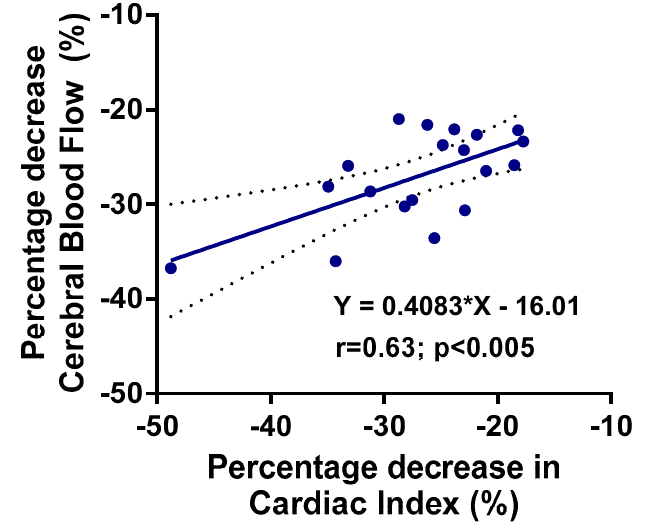
Figure 2. Stroke volume index in ml/m 2 supine and at the end of a 20 degree tilt in severe ME/CFS patients (panel A ). Cardiac index in l/min/m 2 supine and at the end of a 20 degree tilt in severe ME/CFS patients (panel B ).